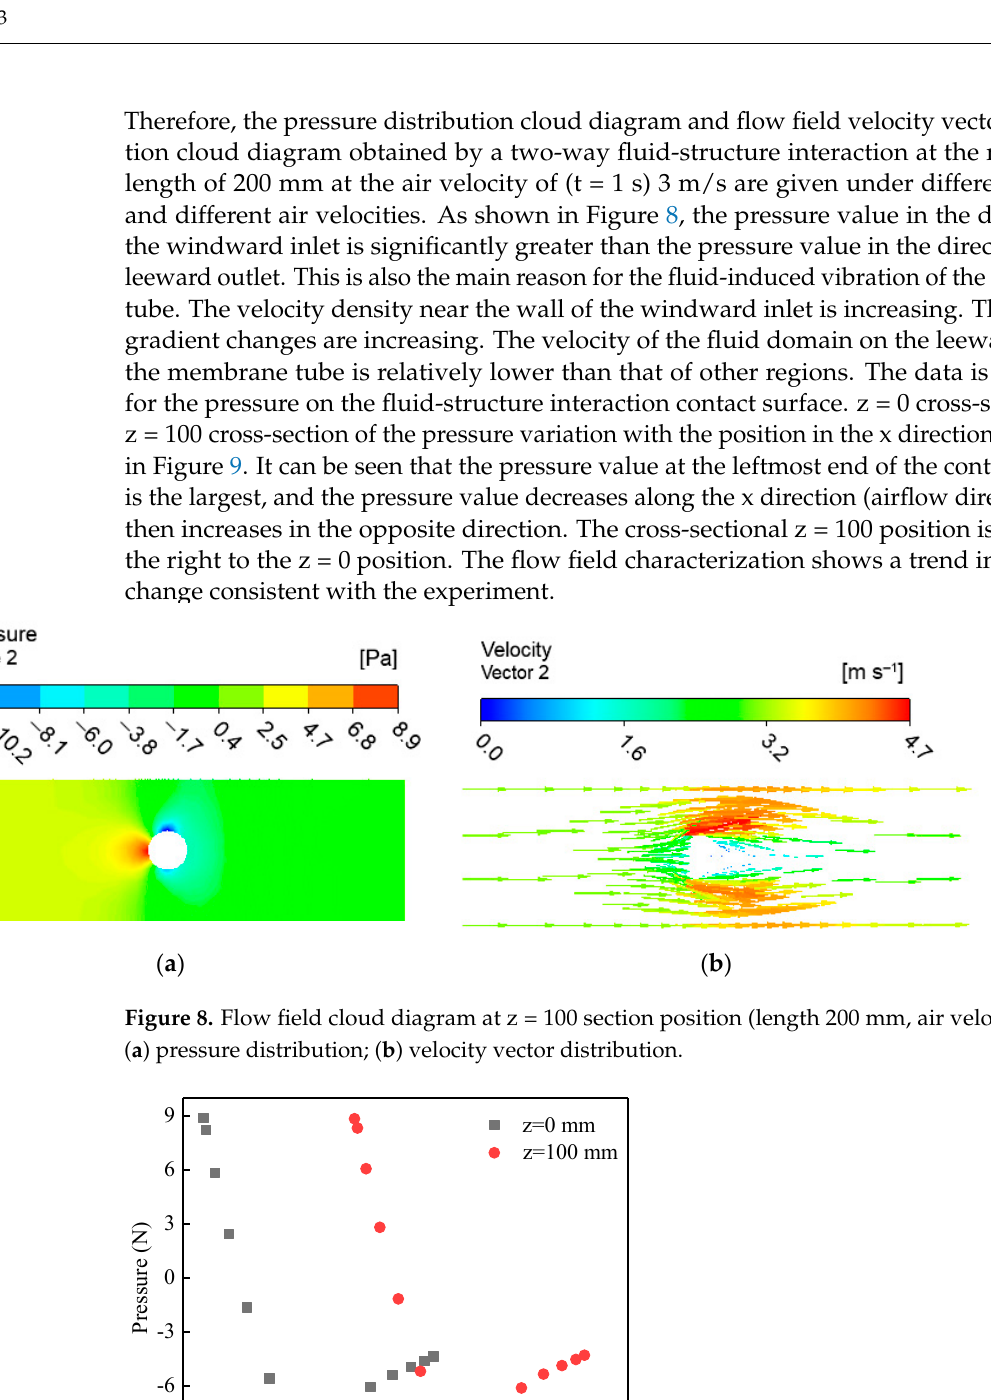
( b ) Figure 7. Cloud diagram of total deformation and equivalence force distribution (length 200 mm, air velocity 3 m/s). ( a ) Equivalent stress (MPa); ( b ) Total deformation (mm).